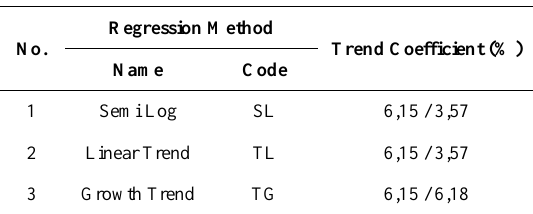
Table 5. Test coefficient values